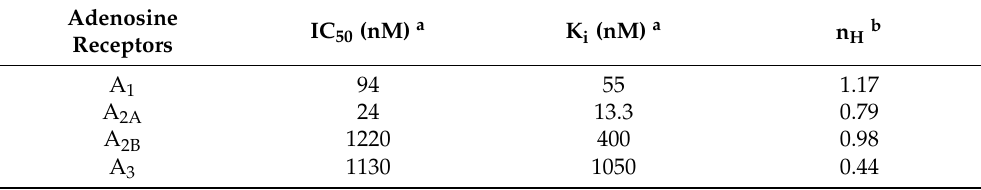
Table 2. Selectivity of compound 11o toward human adenosine receptors based on its binding activities.